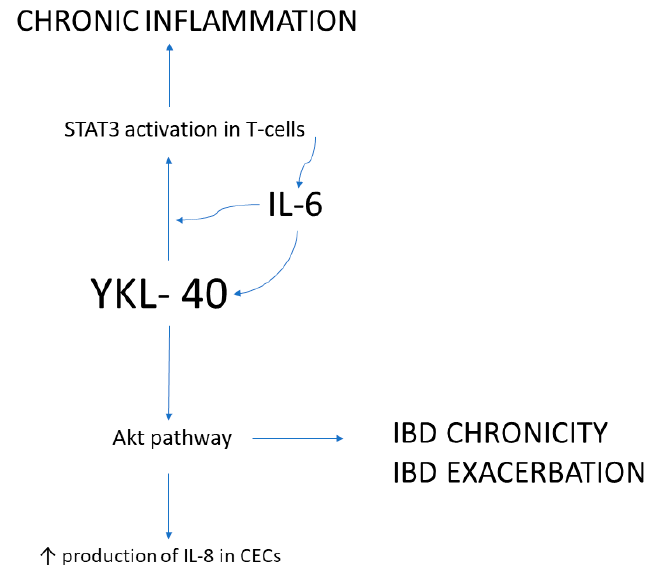
Figure 1. YKL-40 in inflammatory bowel diseases (IBDs).